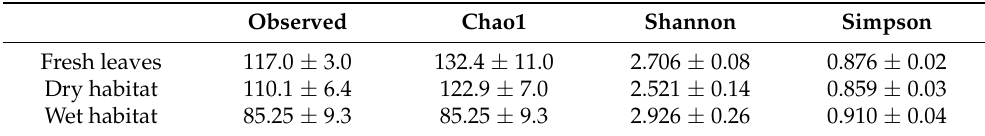
Figure 1. A nonmetric multidimensional scaling (nMDS) ordination for fungal communities from the fresh leaves and Phragmites australis leaves decomposing in dry or wet habitat with accompa- nying stress value. Legend: Different colours represent the taxonomic classes of the top 20 most abundant taxonomic families included in the analysis. Different shapes represent the individual habitats (dry/wet) and fresh leaves. Table represents p -values of pairwise perMANOVA for fungal communities in the fresh leaves or leaves decomposing in wet or dry habitat. General perMANOVA was significant at p < 0.001. Table 1. Diversity and richness indicators for fungal communities from fresh leaves or leaves decomposing in wet or dry habitat (average ± SD, n =